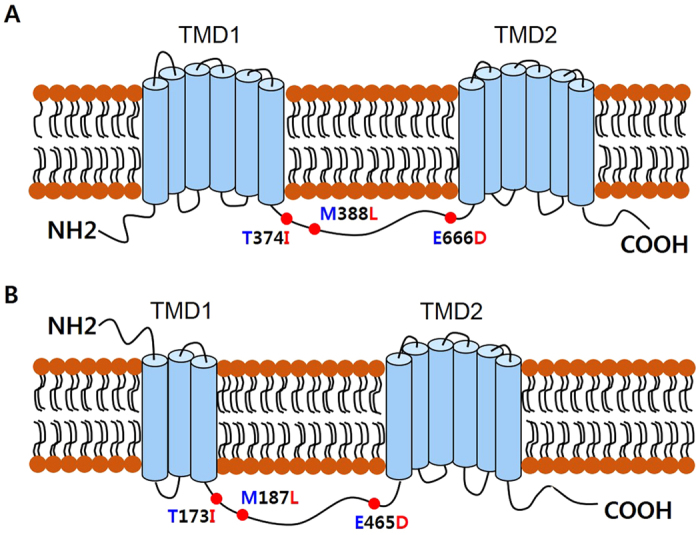
Schematic diagrams of the predicted structures of the MDR49 proteins, encompassing the T374I, M388L, and E666D for MDR49A; T173I, M187L, and E465D for MDR49B amino acid replacement sites.(A) Twelve transmembrane segments in two transmembrane domains (TMD 1 and TMD 2) were predicted in the MDR49A isoform. (B) Nine transmembrane segments were predicted in two TMDs in the MDR49B isoform. Amino acid replacements that may result in structural alterations are indicated by red dots. Blue letters represent 91-C; red letters represent 91-R.